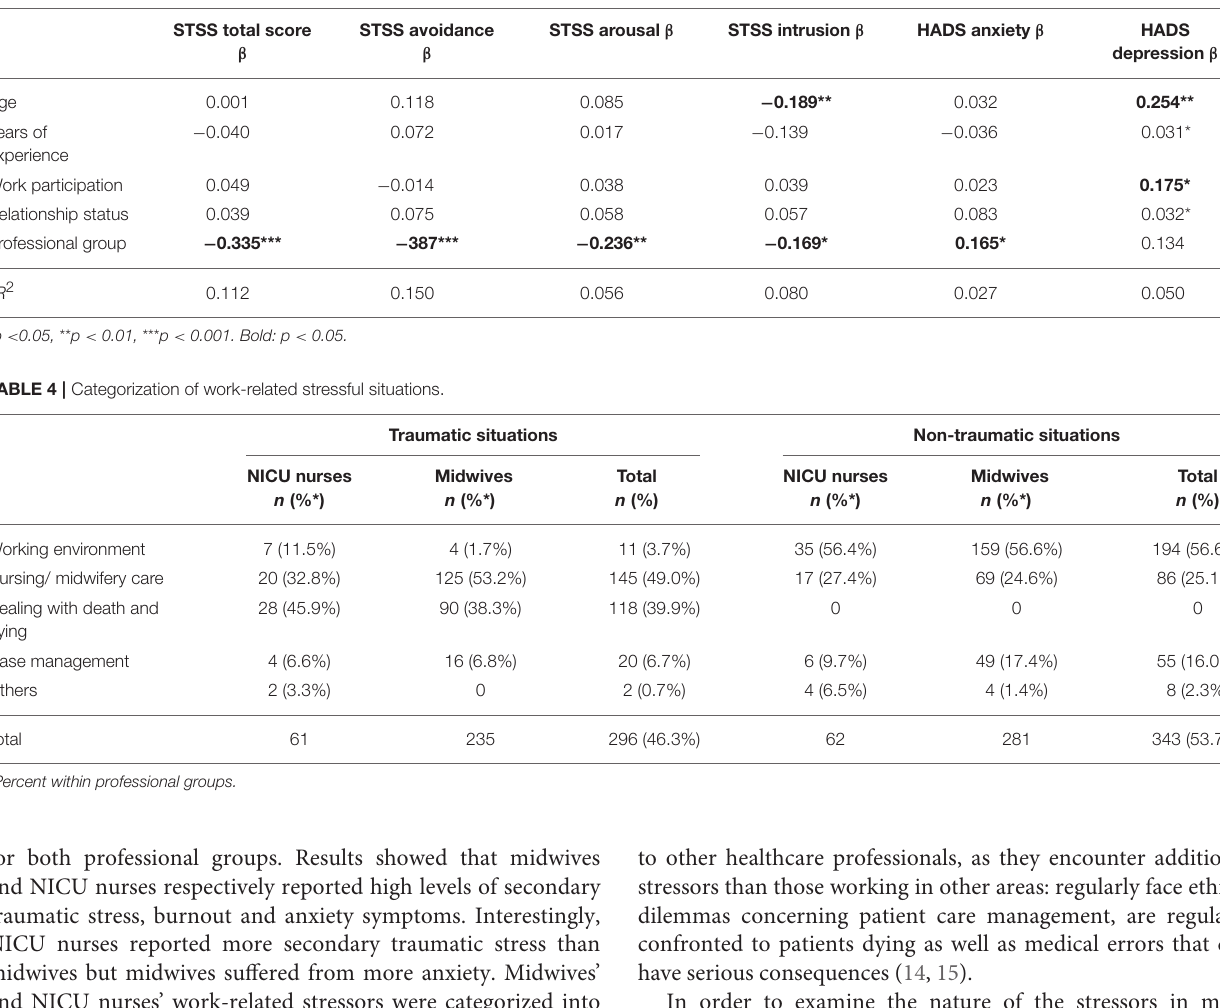
TABLE 3 | Multiple regression analyses.